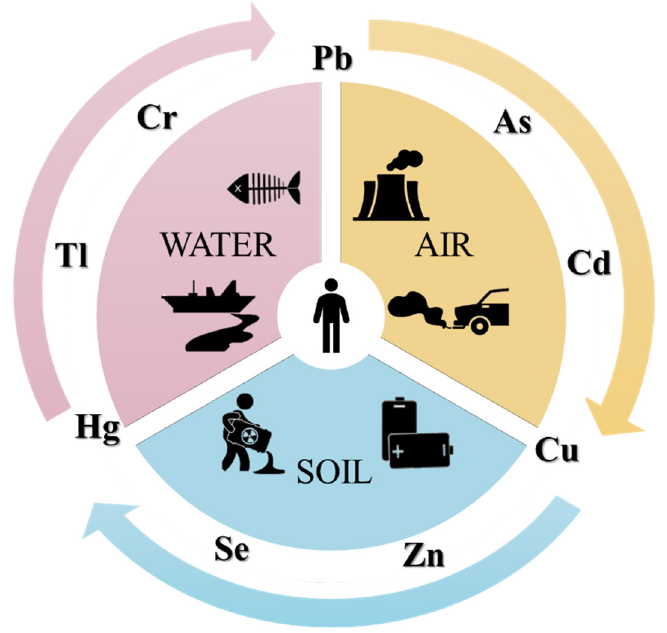
Figure 2. Schematic representation of heavy metals contamination in water, air, and soil environ-